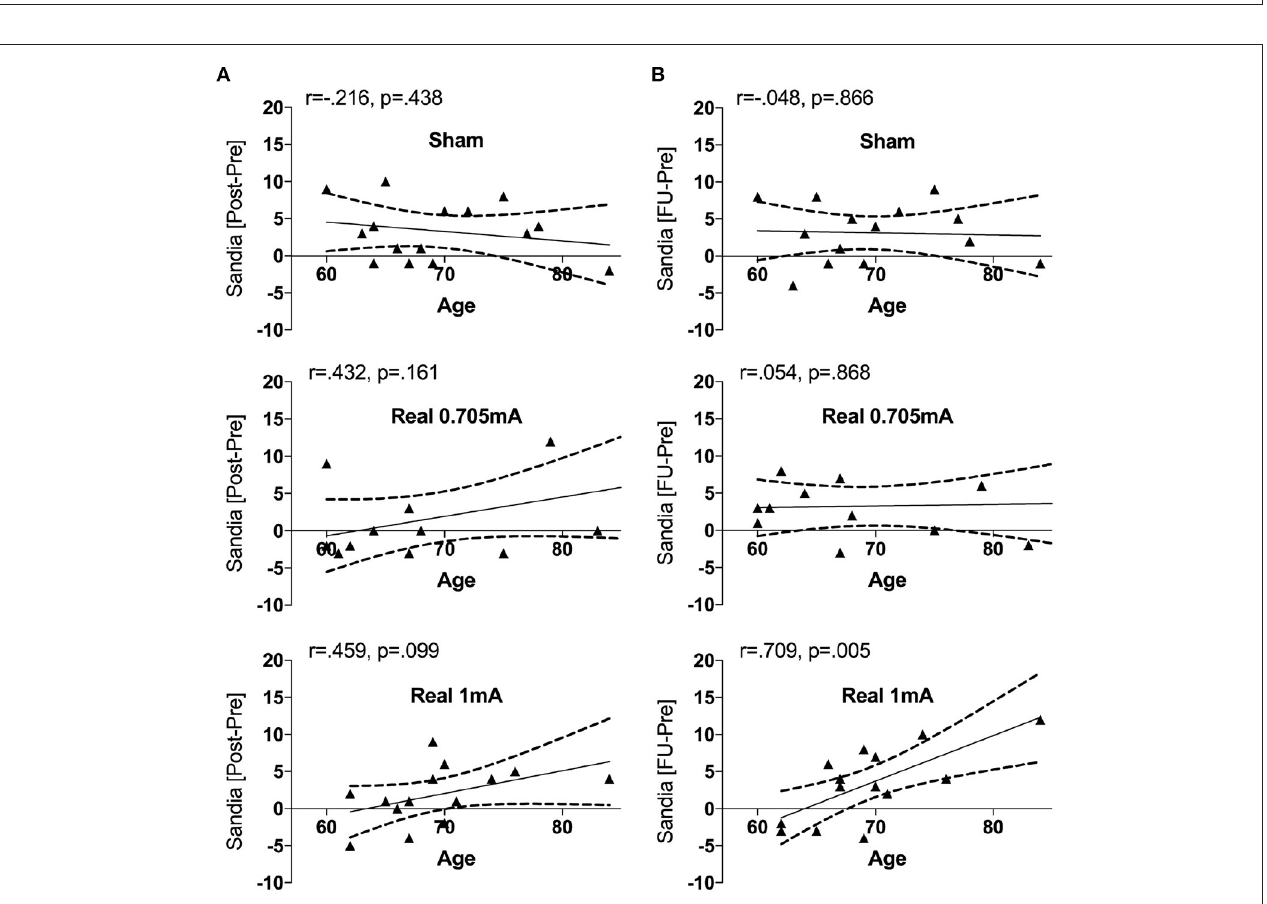
FIGURE 3 | Correlations between the change in Sandia performance and age in the three intervention groups. Age was associated with improvement in performance in the group receiving 1mA tRNS, indicating that older participants profited significantly more from tRNS than younger participants. During the intervention (A) this association was marginal, while it was significant from pre to follow-up (B) . The correlation in the group receiving 1mA tRNS was significantly stronger than in the groups receiving 0.705mA tRNS or sham